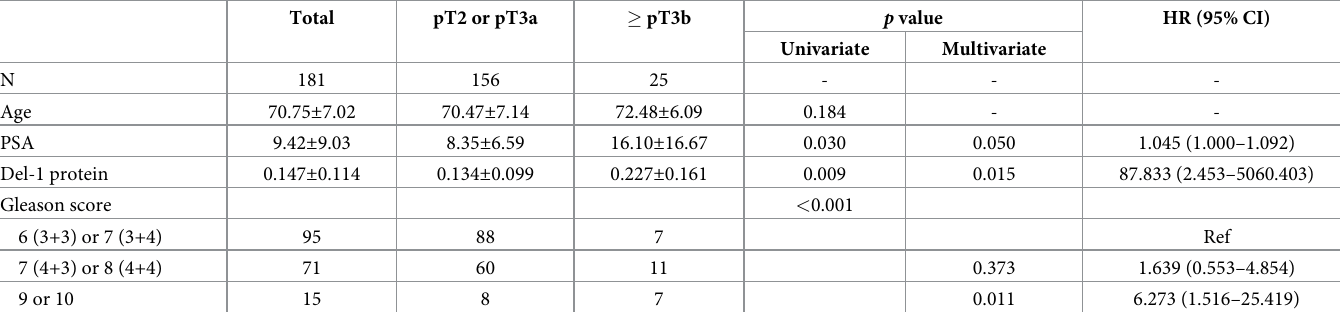
Table 5. Multivariate logistic regression analysis of De1-1 protein as prognostic marker for advanced disease (pT � 3b).